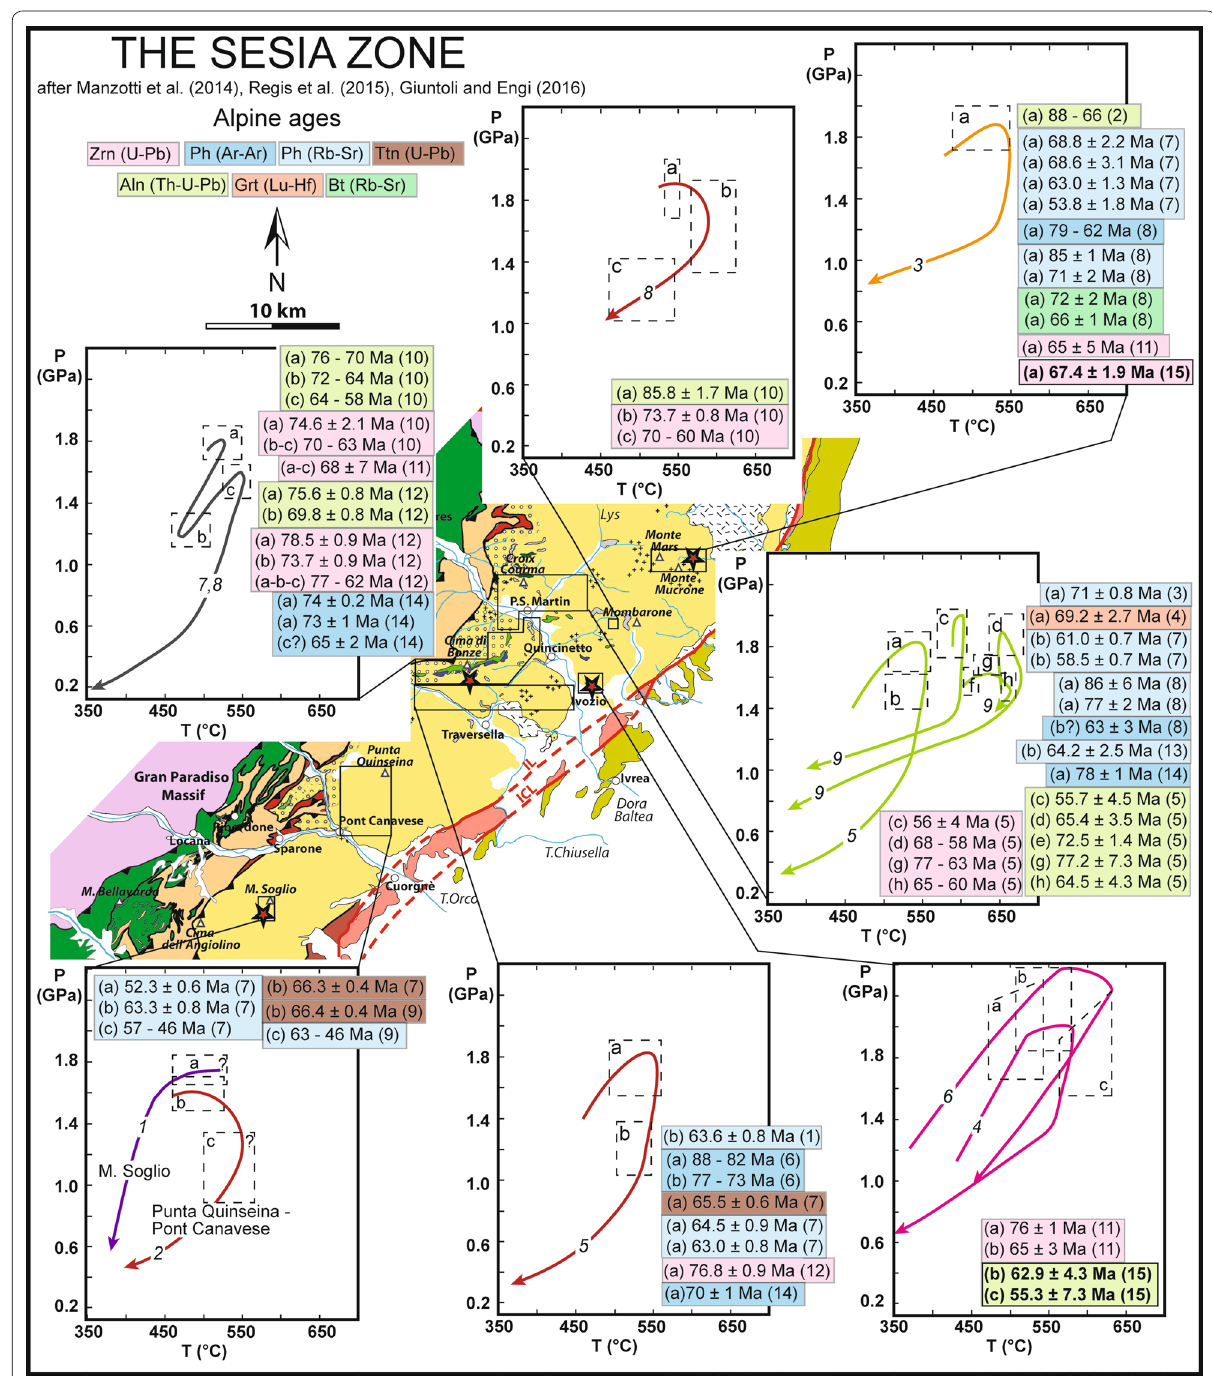
Fig. 2 Geotectonic map of the Sesia Zone (after Manzotti et al. 2014; Regis et al. 2015; Giuntoli and Engi 2016) showing age data for the Alpine metamorphism in the Eclogitic Micaschist Complex (legend in Fig. 1). Age data are from: (1) Babist et al. (2006); (2) Cenki-Tok et al. (2011); (3) Dal Piaz et al. (2001); (4) Duchêne et al. (1997); (5) Giuntoli et al. (2018a); (6) Halama et al. (2014); (7) Inger et al. (1996); (8) Oberhänsli et al. (1985); (9) Ramsbotham et al. (1994); (10) Regis et al. (2014); (11) Rubatto et al. (1999); (12) Rubatto et al. (2011); (13) Ruffet et al. (1997); (14) Venturini (1995) and (15) this study. P–T paths are from: (1) Pognante (1989a); (2) Inger et al. (1996); (3) Zucali et al. (2002); (4) Zucali et al. (2004); (5) Babist et al. (2006); (6) Zucali and Spalla (2011); (7) Rubatto et al. (2011); (8) Regis et al. (2014); (9) Giuntoli et al. (2018a,